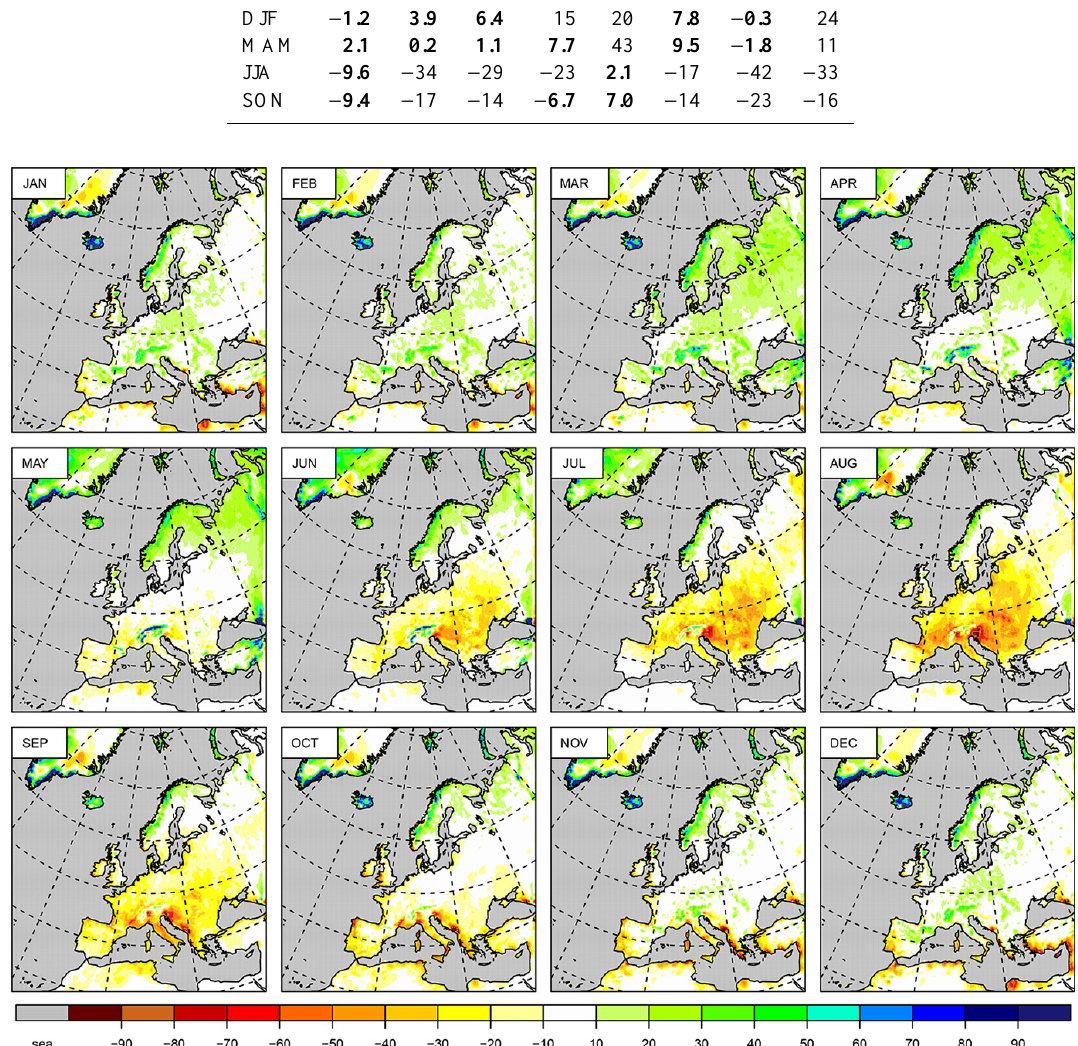
Figure 7. Di ff erences of mean monthly sums of total precipitation [mm] from 1950 to 2010: coastDat2-CCLM minus GPCC6.